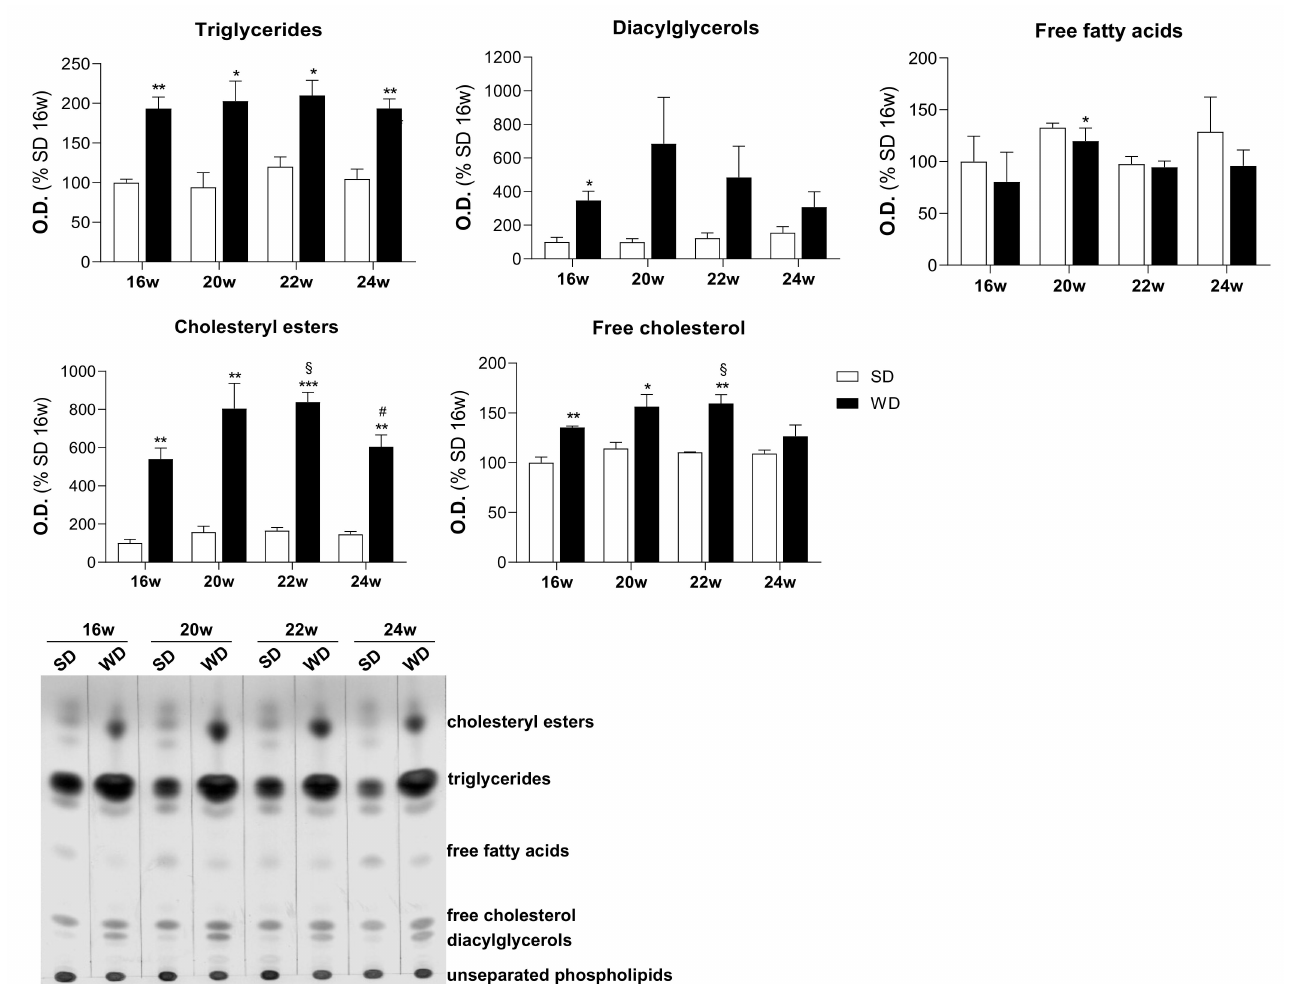
Figure 2. Fatty liver is enriched in triglycerides (TGs) and cholesteryl esters (CEs). Neutral lipids accumulation in TGs, diacylglycerols (DAGs), free fatty acids (FFAs), CEs, and free cholesterol (Chol) and representative thin layer chromatography image. Number of replicates = 3. All data are expressed as the mean ± SEM. (*) vs. SD, (§) vs. 16 w, (#) vs. 22w ( p < 0.05); (**) vs. SD ( p < 0.01); (***) vs. SD ( p < 0.001); p values were determined using two-way ANOVA. SD, standard chow diet; WD, Western